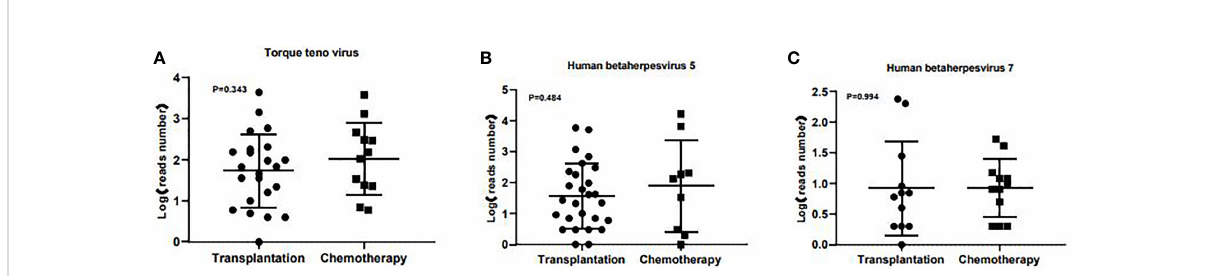
FIGURE 4 The number of reads detected by mNGS for torque teno virus , HHV-5 and HHV-7 in the transplantation and chemotherapy groups. There was no signi fi cant difference in the number of reads detected by mNGS for torque teno virus (A) , HHV-5 (B) and HHV-7 (C) among the common infectious pathogens in the two